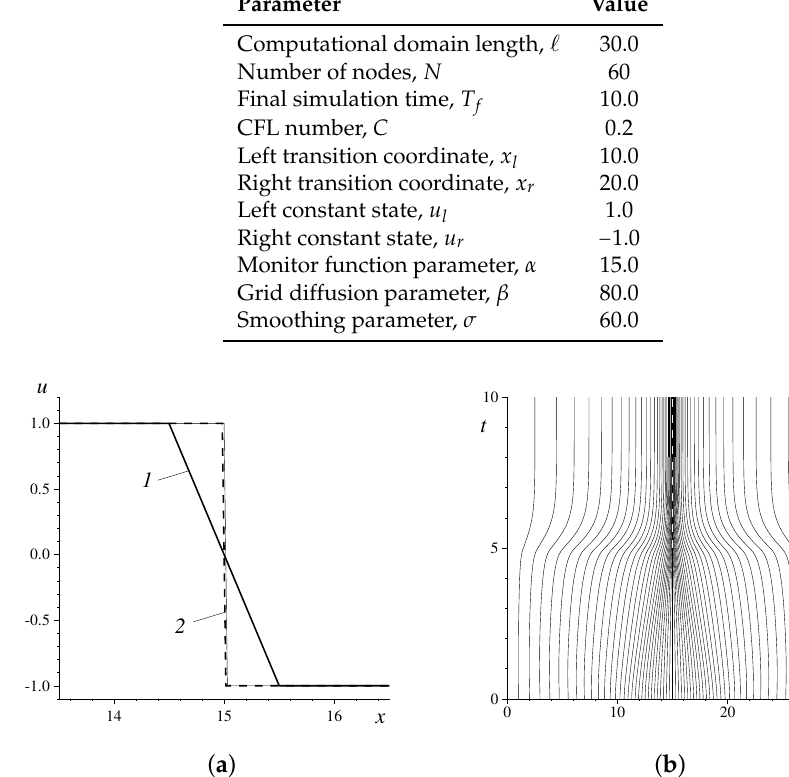
Figure 3. The stationary shock wave formation in the Burgers–Hopf equation: ( a ) A comparison of different profiles (The thin solid line is the exact solution, (1) is the numerical solution on the uniform mesh, and (2) is the solution on the moving mesh); ( b ) the trajectories of grid nodes in space–time. Note that Figure 3a shows only a zoom of the computational domain.